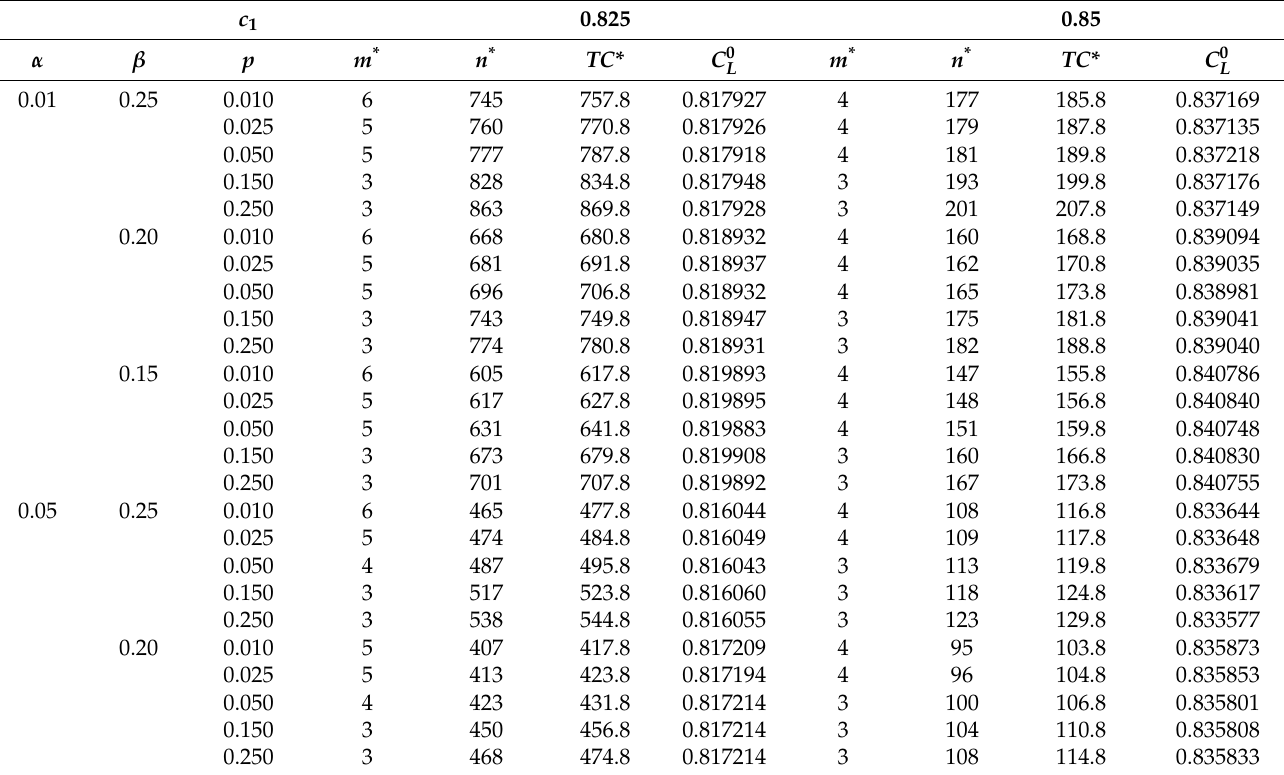
Table A1. The optimal m *, n *, related total cost TC* and the critical value for c 1 = 0.825, 0.85